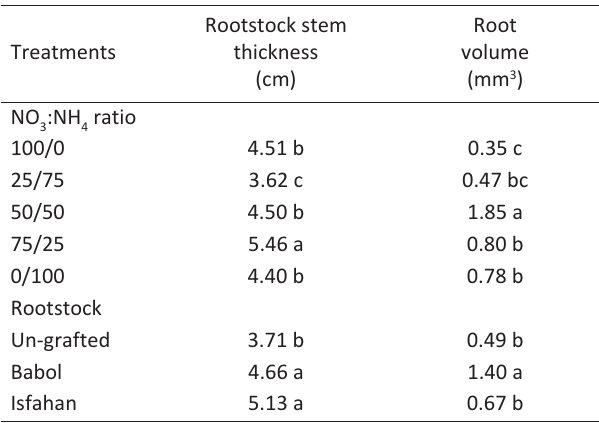
Table 4 ­ Effects of NO :NH ratio and rootstocks on root volume 3 4 and cucumber rootstock